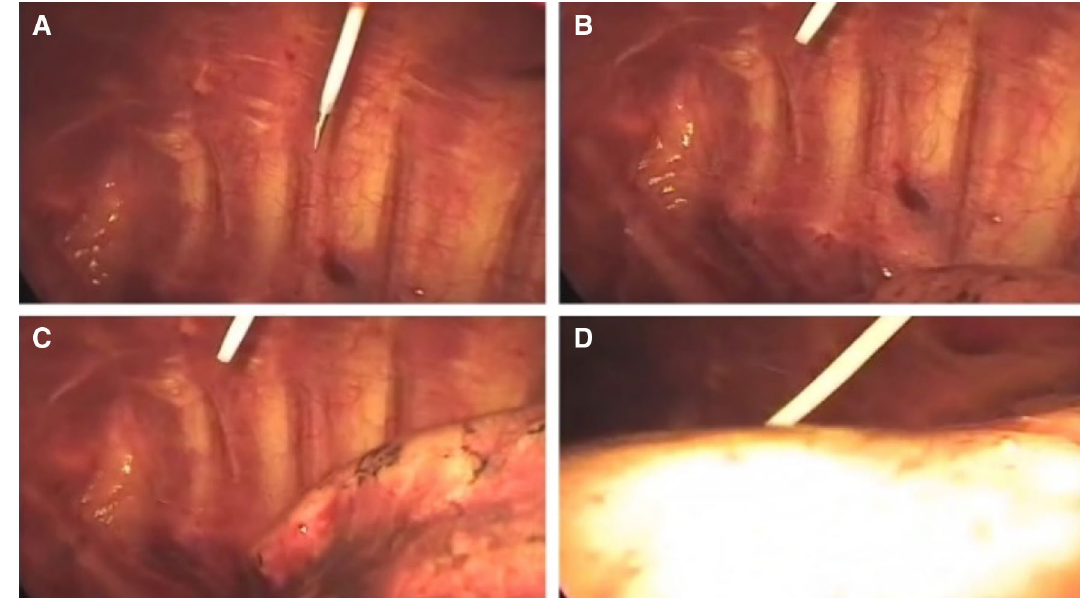
Figure 4. Sequence of needle decompression under the thoracoscope in the second part of the experiment: ( A ) The angiocatheter embedded with optical fibers was inserted into the iatrogenic pneumothorax with the aid of our proposed system. ( B ) The inside introducer needle embedded with optical fibers was removed and the outside plastic sheath was left in the pleural cavity. ( C ) Beginning of lung re-expansion after the iatrogenic pneumothorax. ( D ) Near-full re-expanded lung after needle